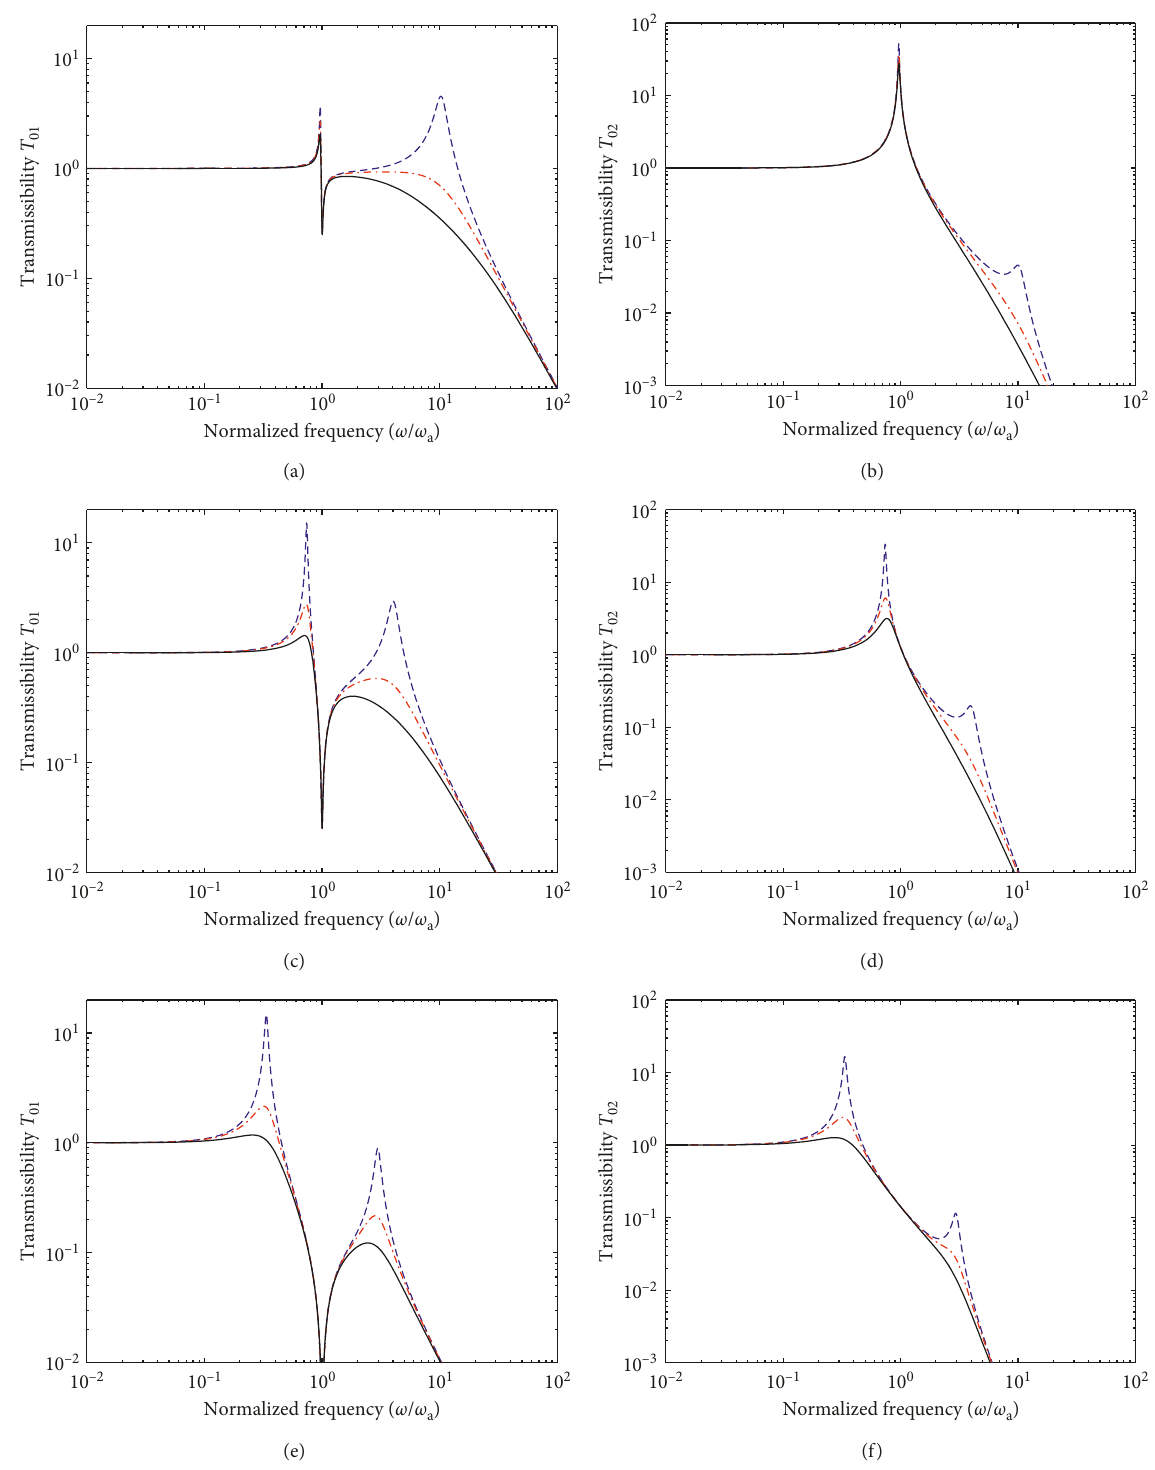
Figure 2: Transmissibility functions in magnitude T m m 7 and ζ a 0 . 01. Three base damping ratios ζ b σ a / (cid:31) (cid:31) (cid:31) three coupling cases ω b / ω a 10 (a, b), 3 (c, d), and 1 (e, (cid:31)